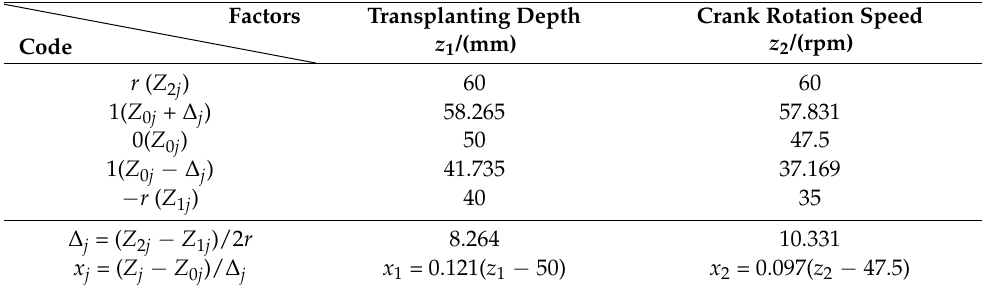
Table 2. Experimental factor coding